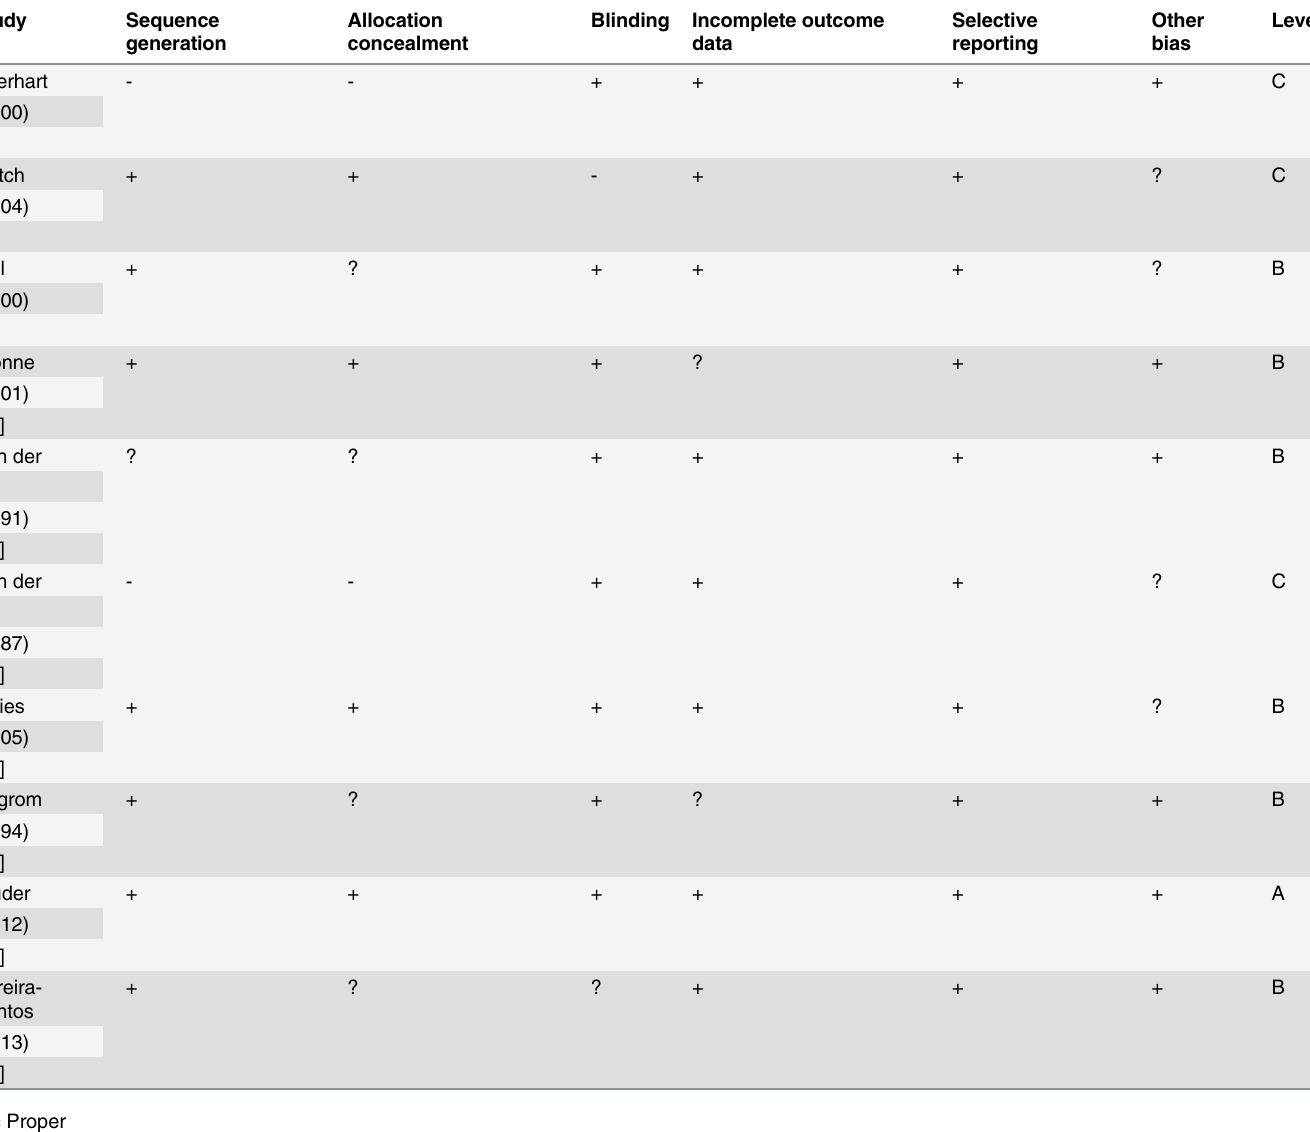
Table 2. Customized form for assessing risk of bias of included